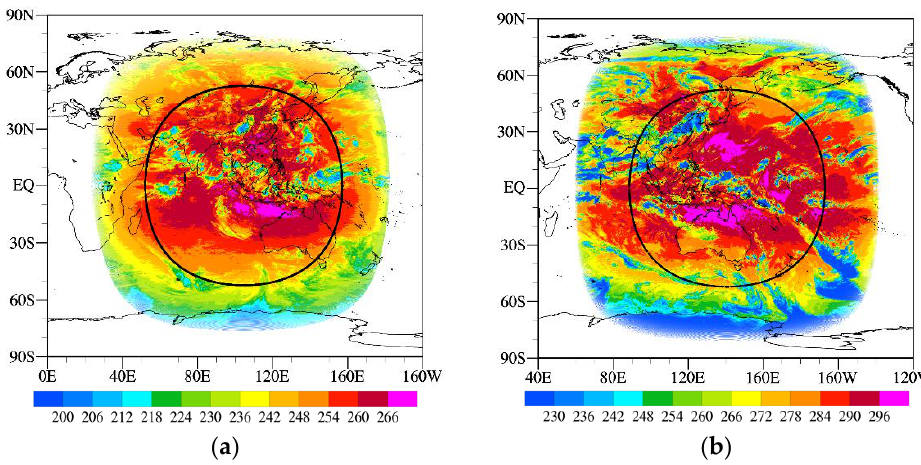
Figure 1. Spatial distributions of the observed brightness temperature (unit: K) of the AGRI, channel 14 ( a ) on 1 July 2019, and AHI, channel 16 ( b ) on 1 July 2016. Black curves show the domain with a satellite zenith angle of less than 60°.